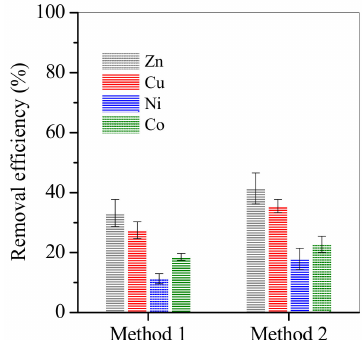
Figure 8. Reuse of the precipitate of hydrolyzed SP2 for electroplating wastewater treatment. In the figure, Methods 1 and 2 represent NaCl solution elution and high-temperature calcination, respectively.